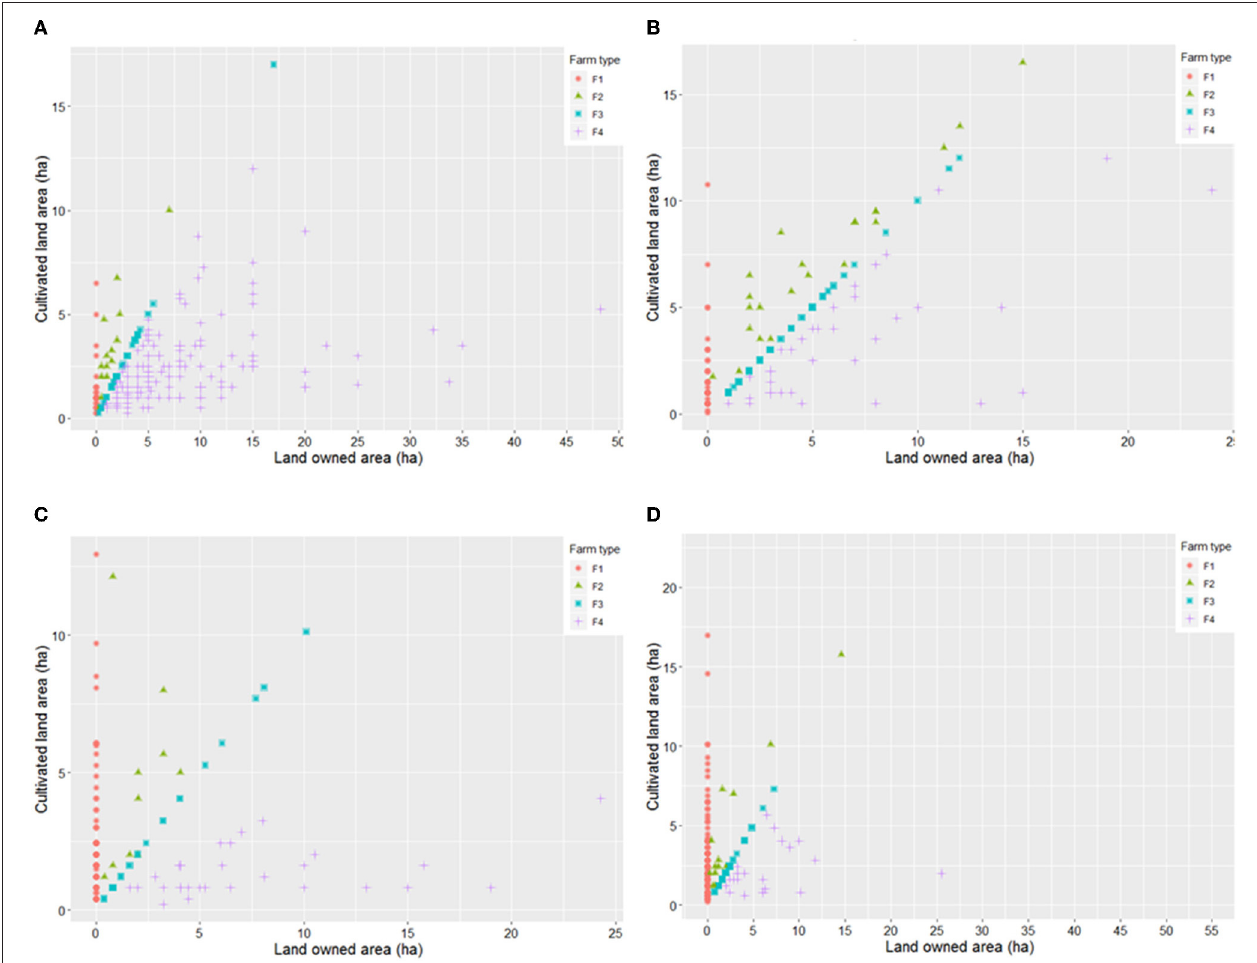
FIGURE 2 | Cultivated area against land owned for all farm households in (A) Bouaké [top left], (B) Gagnoa [top right], (C) Ahafo Ano North [bottom left], and (D) Ahafo Ano South [bottom